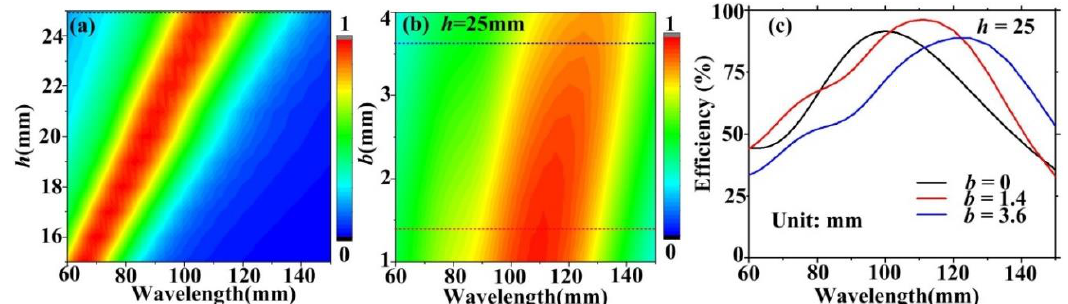
Figure 2. ( a ) The efficiencies of the typical monopole antenna with different lengths ( h ); ( b ) the efficiencies of the plasmonic monopole antenna with different groove depths ( h = 25 mm); and ( c ) the efficiencies of the plasmonic monopole antenna when the groove depth b is 0 mm, 1.4 mm, and 3.6 mm.